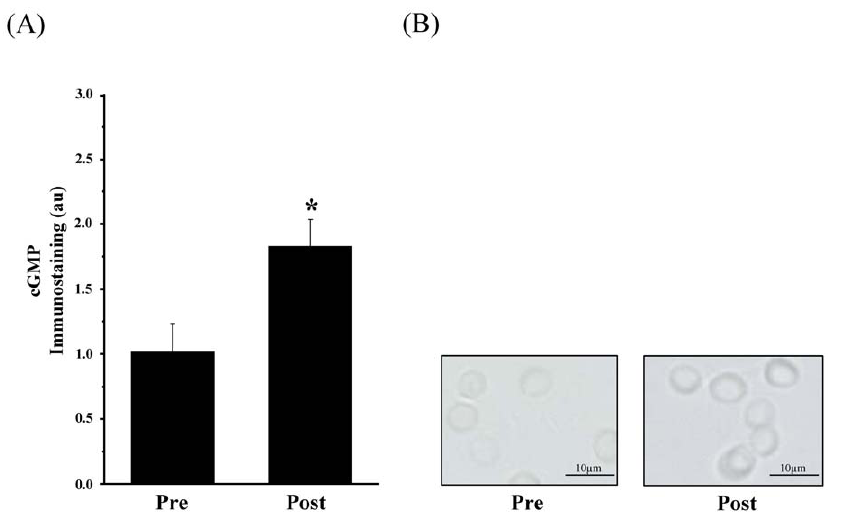
Figure 3. Change in cGMP before (Pre) and after (Post) AMRT determined by immunohistochemistry. (A) Bars show statistical analysis of gray values (au) between Pre and Post conditions. The cGMP signal in human RBCs significantly increased at the end of the test (Post) ( P , 0.05). (B) Pictures show representative cGMP stainings before and after the test, respectively. Magnification for all images was 400-fold. Data in (A) are presented as mean 6 S.E.M of n=6.